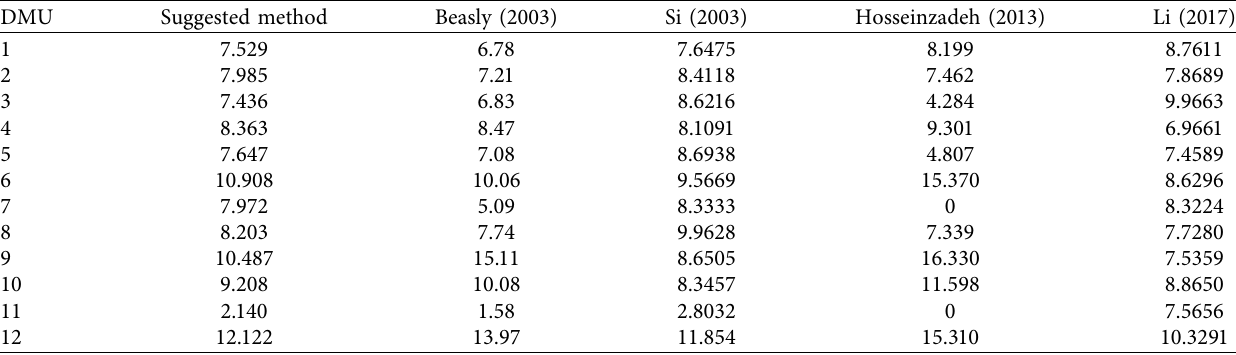
Table 3: Allocations using common weights.